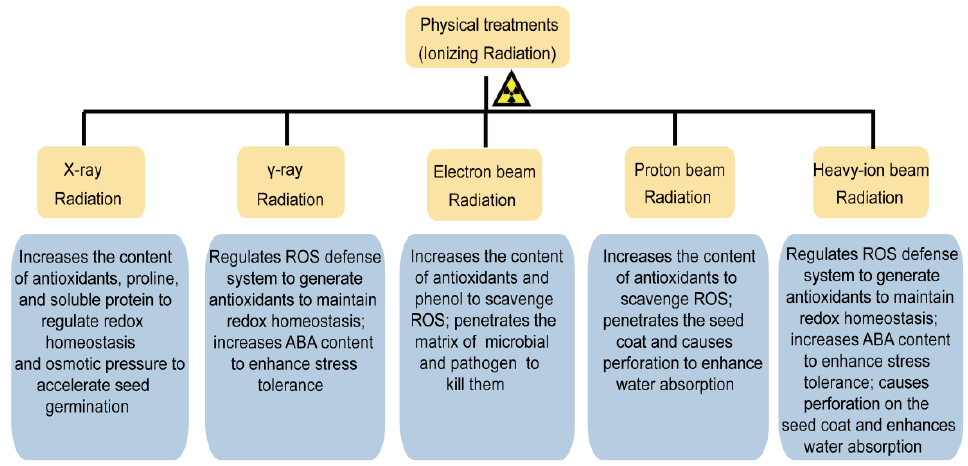
Figure 4. X-ray and γ -ray, electron beams, proton ions, and heavy-ion beams of physical agents used for seed priming and their mode of action.